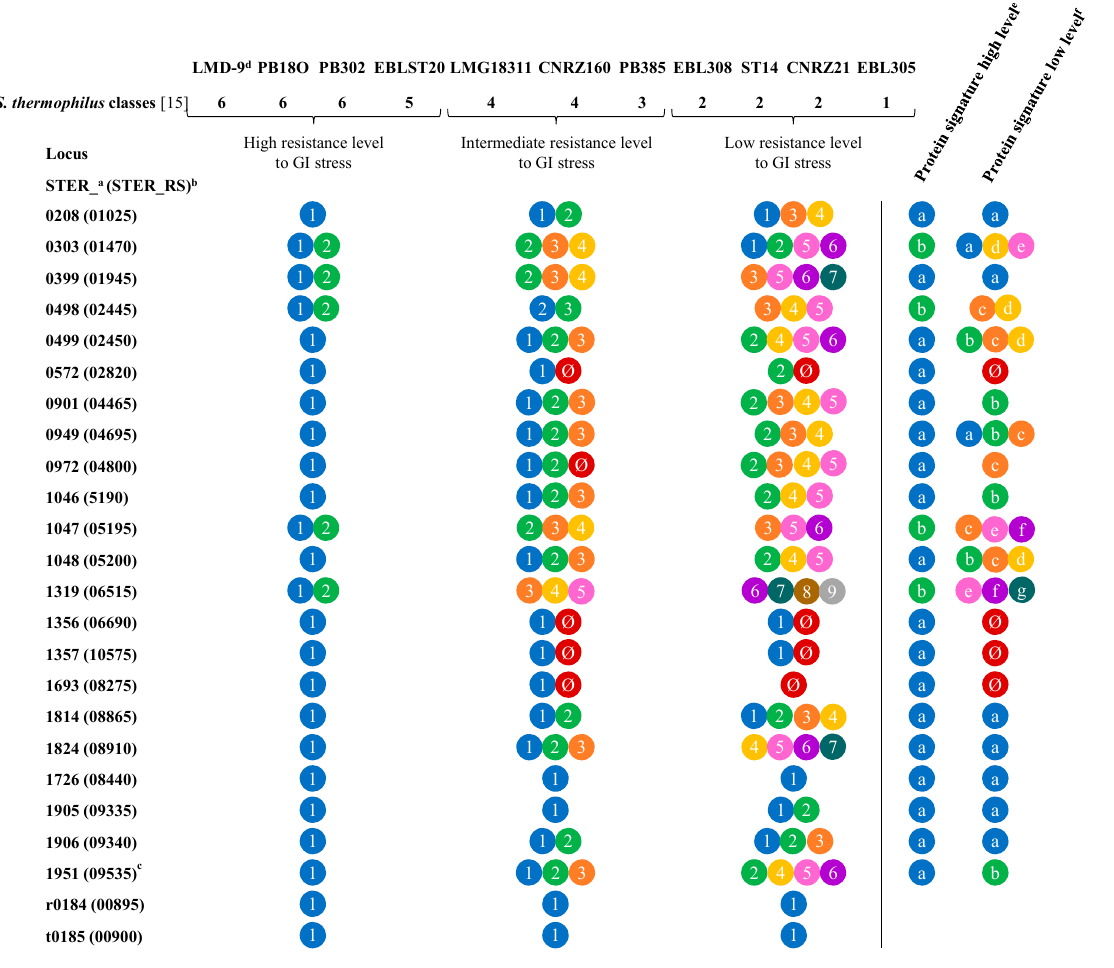
Figure 6. Schematic overview of allele variability of R-IVET activated genes identified in TIM-1 and fecal batch cultures among strains displaying different properties of resistance against GI stress and deduced protein signature. Colors/numbers correspond to different alleles of R-IVET activated genes that were identified. Different proteins signatures are given by different colors/letters. The full name of each gene is detailed in Table S3 (Supplementary Materials). Ø No PCR amplicon; a locus annotation from 28 January 2014; b locus annotation from 30 July 2015 from NCBI; c according to Junjua et al. [15]; d LMD-9 used as a reference strain for comparison; e types of proteins found in strains exhibiting a high level of resistance against GI stress; f types of proteins found in strains exhibiting a low level of resistance against GI stress.